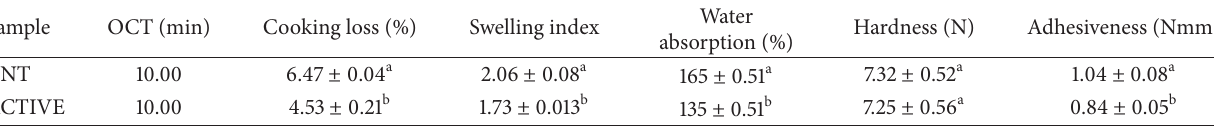
Table 2: Cooking quality of dry spaghetti samples.